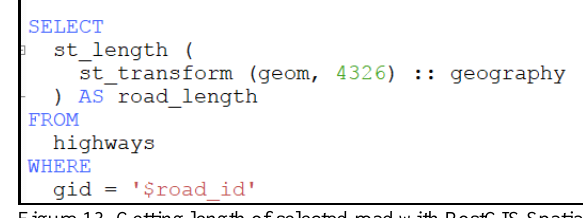
Figure 10. Addition of disturbances on the selected route to the system